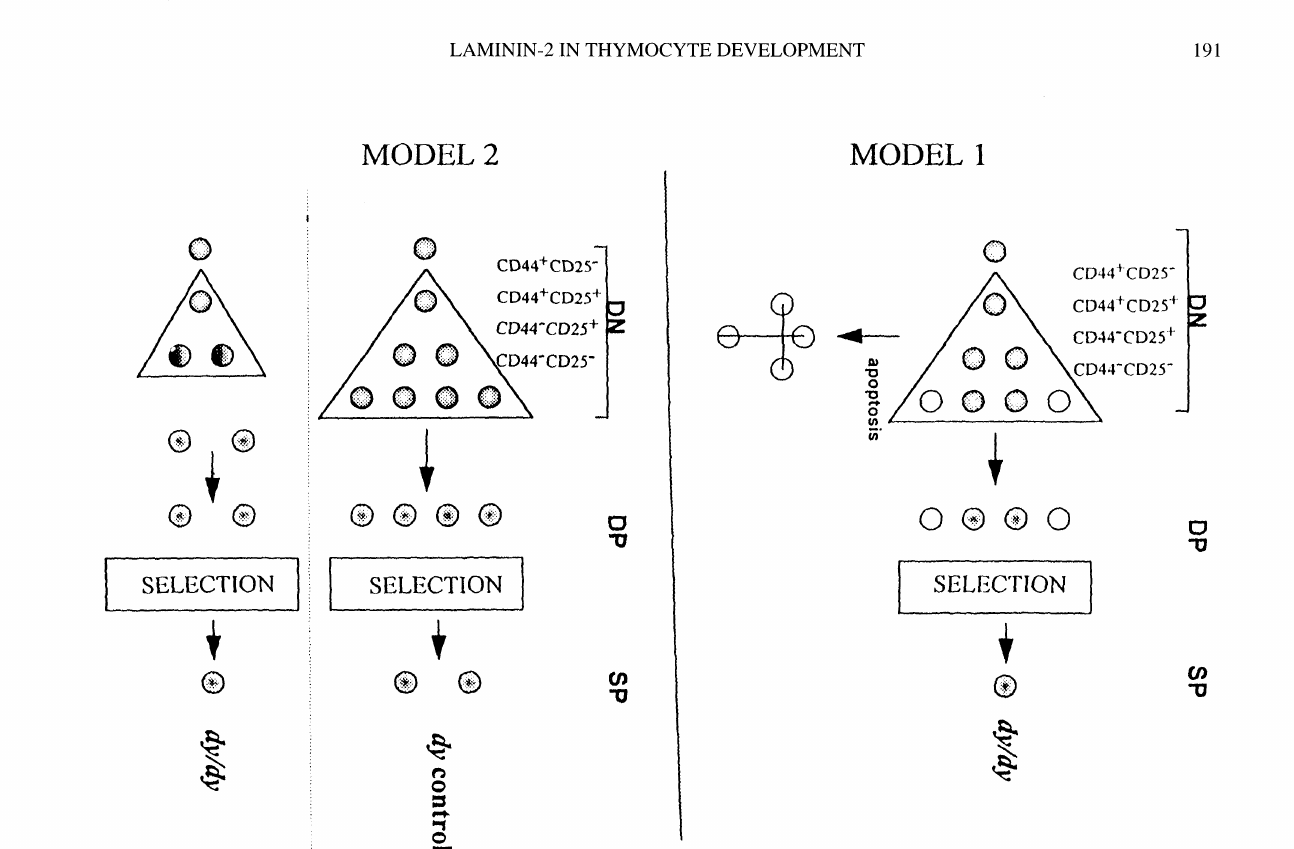
FIGURE 6 Models to explain the effect of the dy mutation on thymocyte development. Model we propose that laminin-2 provides a sur- vival signal needed by thymocytes at specific developmental checkpoints in their early maturation. The absence of this signal results in increased cell death early in development and thus a lack of cells moving along the thymic maturation pathway. Specific populations which have a more stringent requirement for this signal may then be underrepresented relative to other populations. Lack of a survival signal would be predicted to lead to an increase in programmed cell death among the populations which require the signal. Model 2 alternatively, we propose that laminin-2 could provide a proliferative signal to the developing thymocytes. The loss of this signal would diminish the number of cells progressing along the route to maturation. This model would affect overall cell number and could result in underrepresentation of specific populations in which this proliferative signal was required. This model would not predict an alteration in programmed cell death